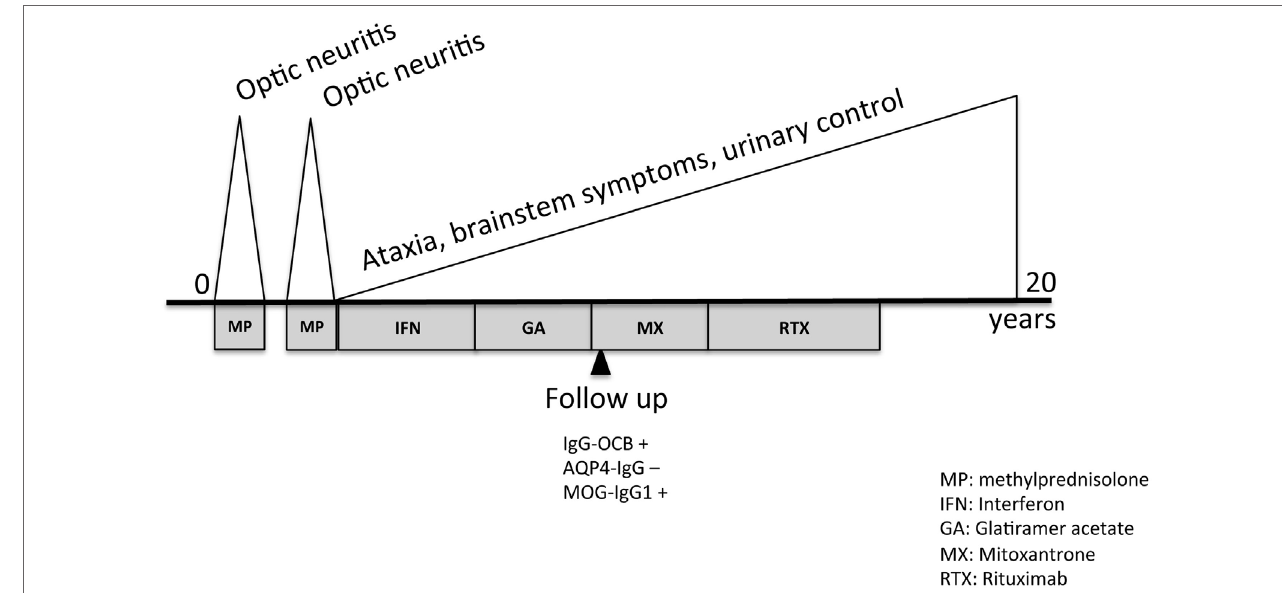
FIGURe 2 | Timeline of clinical course and